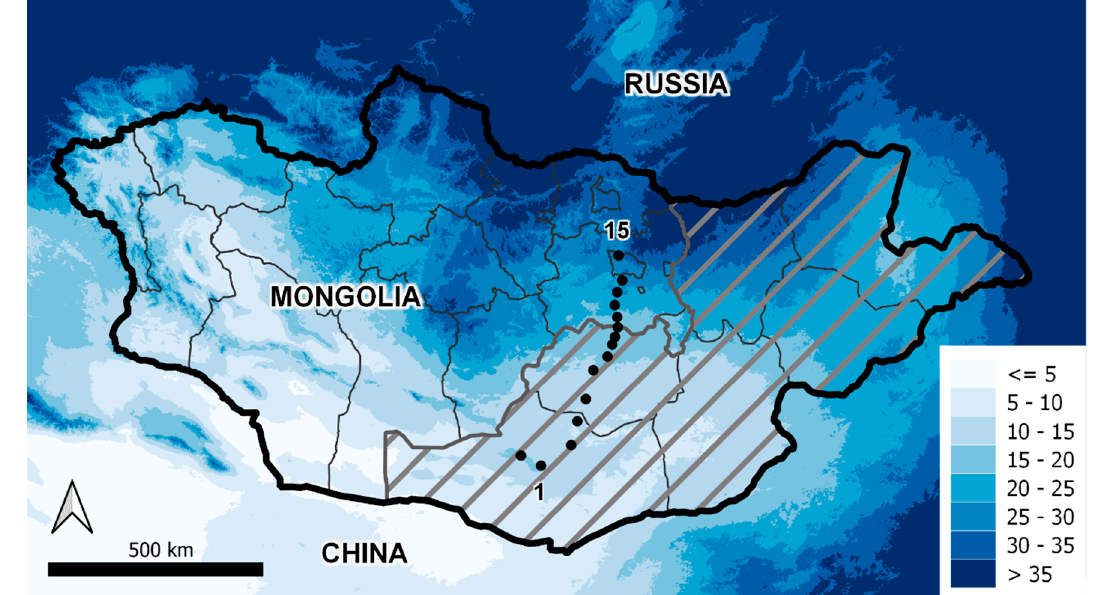
Figure 1. Location and average annual precipitation (cm; [32]) at simulated sites in Mongolia. Fixed contrasts were applied at 15 sites (black points) arrayed across a precipitation gradient in the center of the country. The hashed area shows the Gobi-Steppe ecoregion, where gridded simulations were conducted. Sites were numbered 1–15 from south to north; for additional site information, see Appendix A, Table A1.